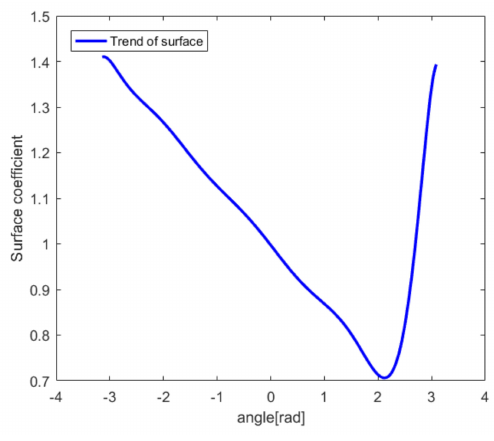
Figure 16. Surface change curve.